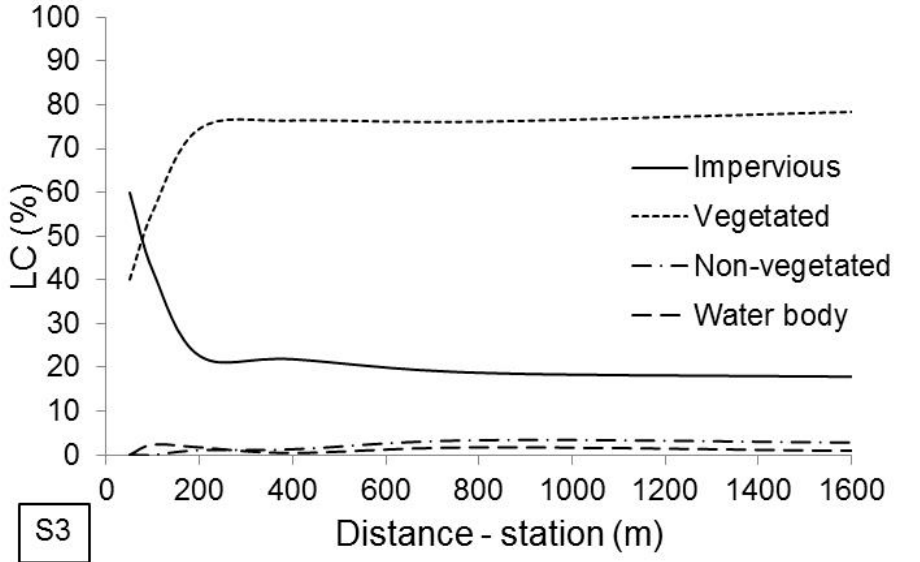
Figure 7. Spatial variation of the LC type with respect to the stations (measured values). Vegetated: trees/grasslands; nonvegetated: bare soil; impervious: roofs/pavements/footpaths; water body: rivers/lakes/wetlands. S1: impervious LC predominance; S3: vegetated LC predominance.